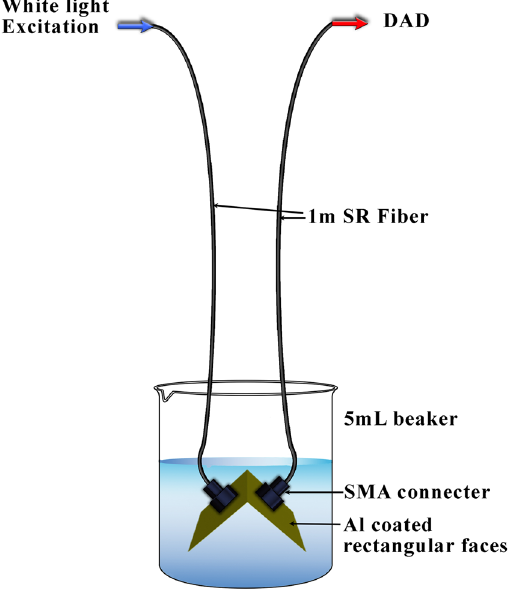
Figure 1. The optical design of Dip Probe Fiber Optic Spectrometer for WLEF